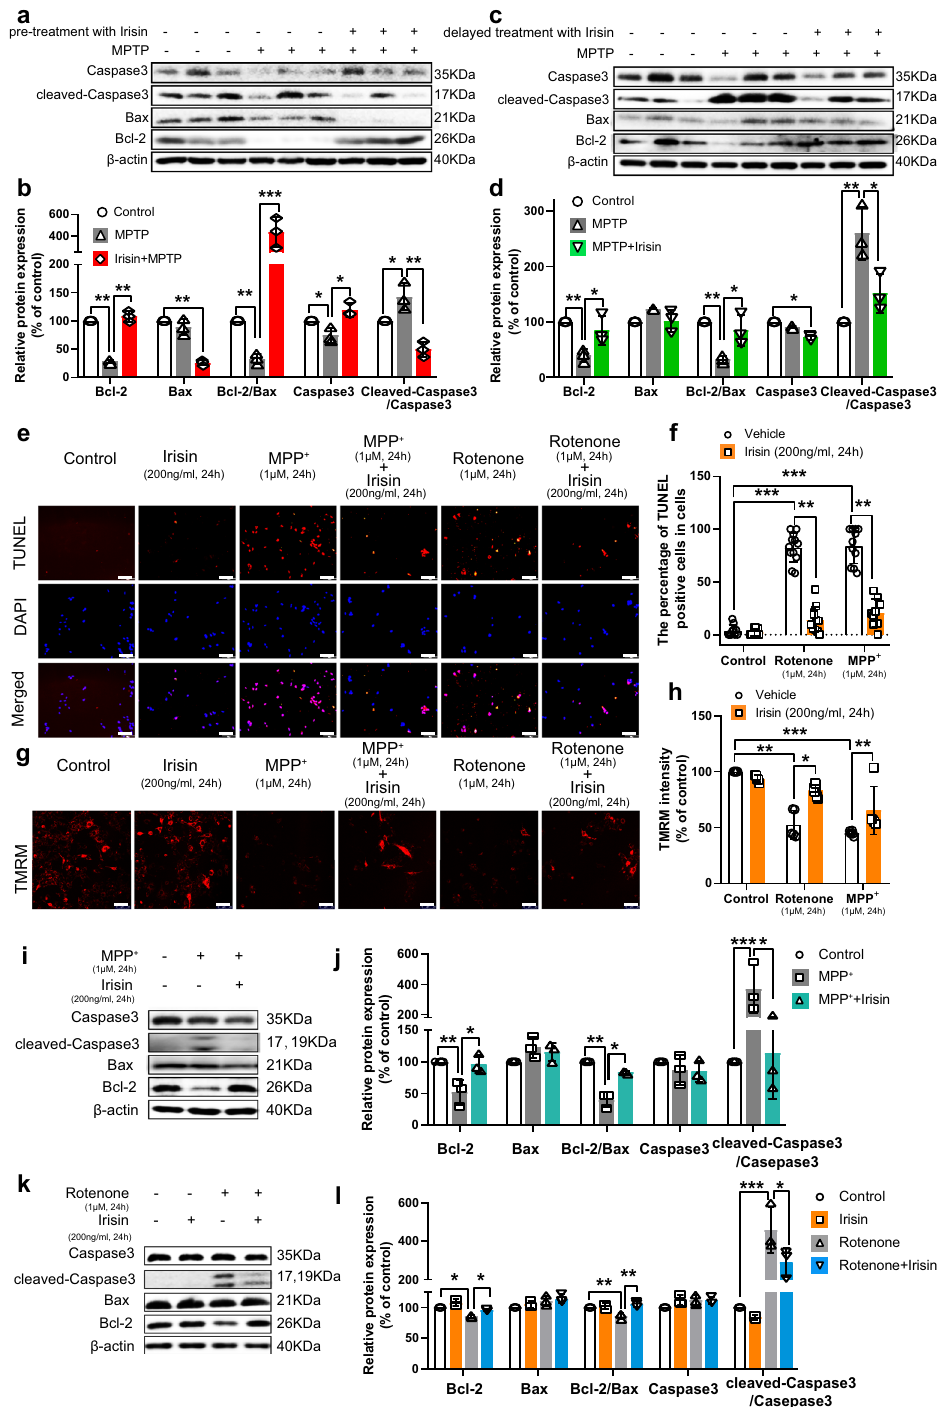
Fig. 2 Peripheral irisin induces apoptosis in PD models induced by neurotoxins. SH-SY5Y cells were seeded and incubated until 80% cell density. And the cells were separately treated with vehicle, rotenone (1 μ M, 24 h), irisin (200 ng/ml, 24 h), MPP + (1 μ M, 24 h), rotenone (1 μ M, 24 h) and irisin (200 ng/ml, 24 h) co-treatment, and MPP + (1 μ M, 24 h) and irisin (200 ng/ml, 24 h) co-treatment. a , b Western blot showing the quanti fi cation of cleaved-caspase3/caspase3 ratio, Bax, Bcl-2, and Bcl-2/Bax ratio in the midbrain of MPTP treated mice receiving pre-treatment with irisin. c , d Western blot showing the quanti fi cation of cleaved-caspase3/caspase3 ratio, Bax, Bcl-2, and Bcl-2/Bax ratio in the midbrain of MPTP treated mice receiving delayed treatment with irisin. e , f Confocal image of cell coverslips showing TUNEL ( + ) cell number in various groups of in vitro experiments. Scale bar, 25 μ m. g , h Confocal image of TMRM showing mitochondrial membrane potential (MMP) in various groups of in vitro experiments. Scale bar, 25 μ m. i , j Western blot showing the quanti fi cation of cleaved-caspase3/caspase3 ratio, Bax, Bcl-2, and Bcl-2/Bax ratio in SH-SY5Y cells treated by MPP + and irisin. k , l Western blot showing the quanti fi cation of cleaved-caspase3/caspase3 ratio, Bax, Bcl-2, and Bcl-2/Bax ratio in SH-SY5Y cells treated by rotenone and irisin. All data are presented as mean ± SEM ( n ≥ 3). ∗ p < 0.05,